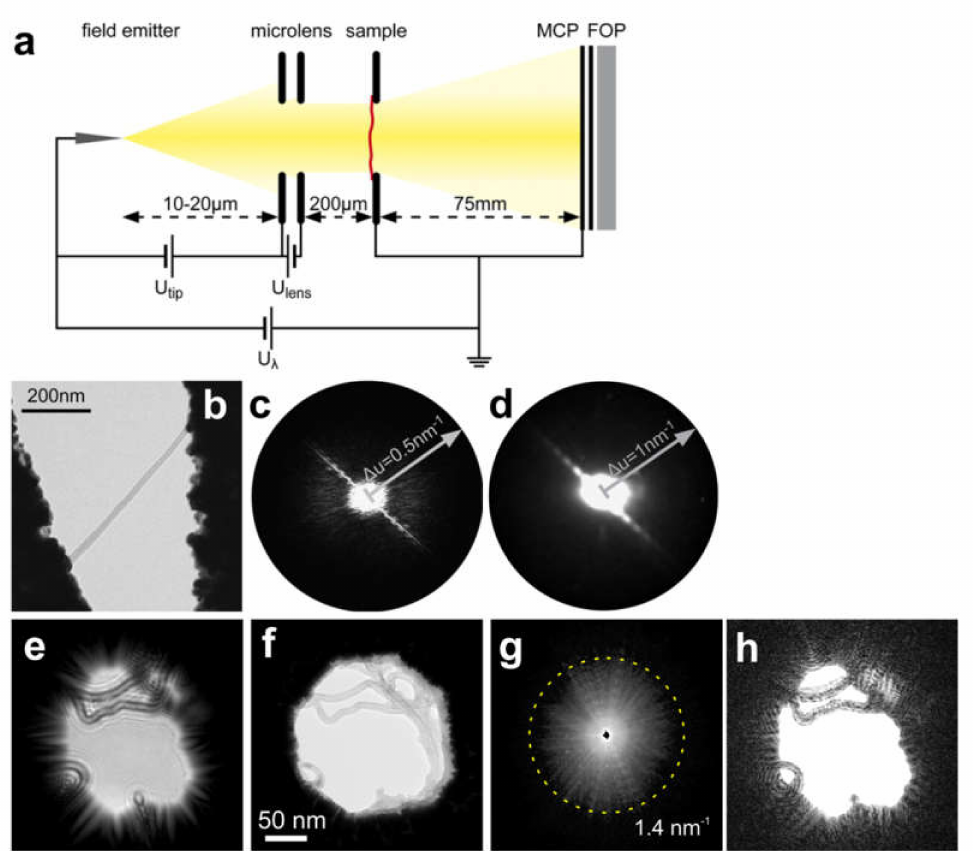
Figure 26. Coherent di ff raction imaging (CDI) with low-energy electrons. ( a ) Experimental arrangement. ( b – d ) CDI of an individual single-walled carbon nanotube (SWCNT). ( b ) TEM image of the sample. ( c ) Fourier transform (FT) of the TEM image. ( d ) Di ff raction pattern of SWCNTs recorded with 186 eV electrons. ( a – d ) reprinted from [121], with permission from Elsevier. ( e – h ) Holographic CDI (HCDI) reconstructions of a bundle of carbon nanotubes [122]. ( e ) In-line hologram recorded using electrons with kinetic energy 51 eV, source-to-sample distance 640 nm, and source-to-detector distance 68 mm. ( f ) TEM image recorded with 80 keV electrons. ( g ) Di ff raction pattern recorded using electrons with kinetic energy 145 eV and source-to-detector distance 68 mm. The highest detected frequencies are indicated by the dashed circle, and the corresponding resolution is R = λ / ( 2 NA ) = 7 Å. ( h ) Reconstructed amplitude distribution of the sample using HCDI. ( e – h ) Adapted from